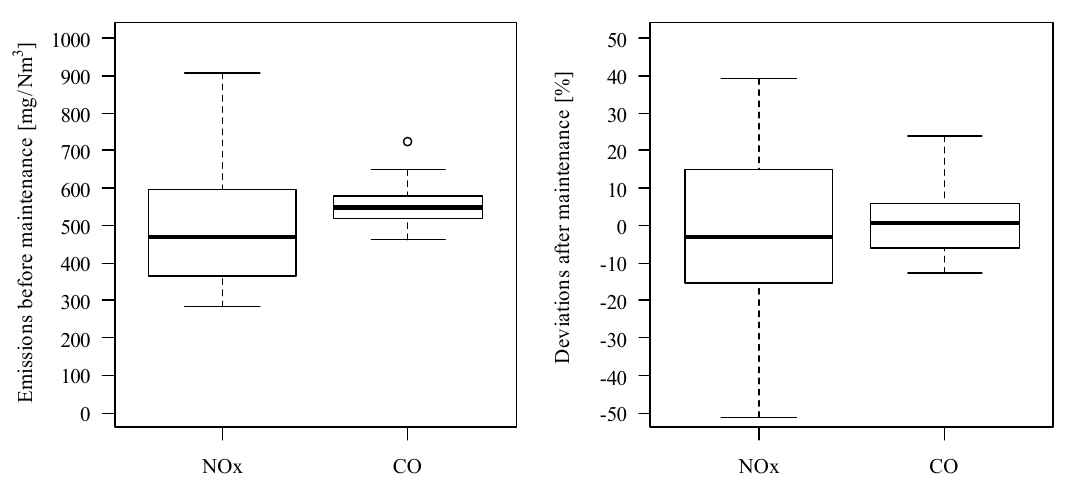
Figure 1. Boxplot of NO and CO emissions five days before maintenance and its change x in percentage points five days after the maintenance over all maintenance